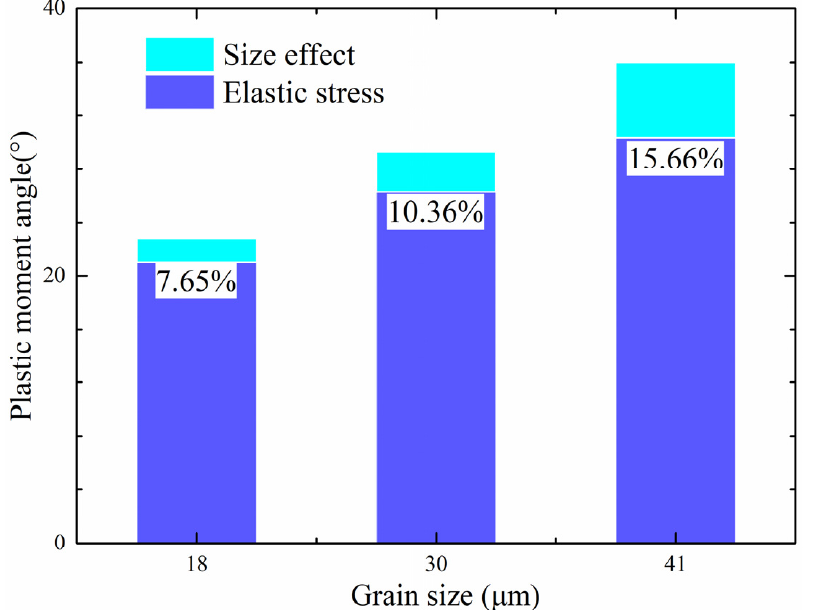
Figure 12. Comparison of the contributions of strain gradient and grain and feature size to springback angles in sheet metal samples with different grain sizes.